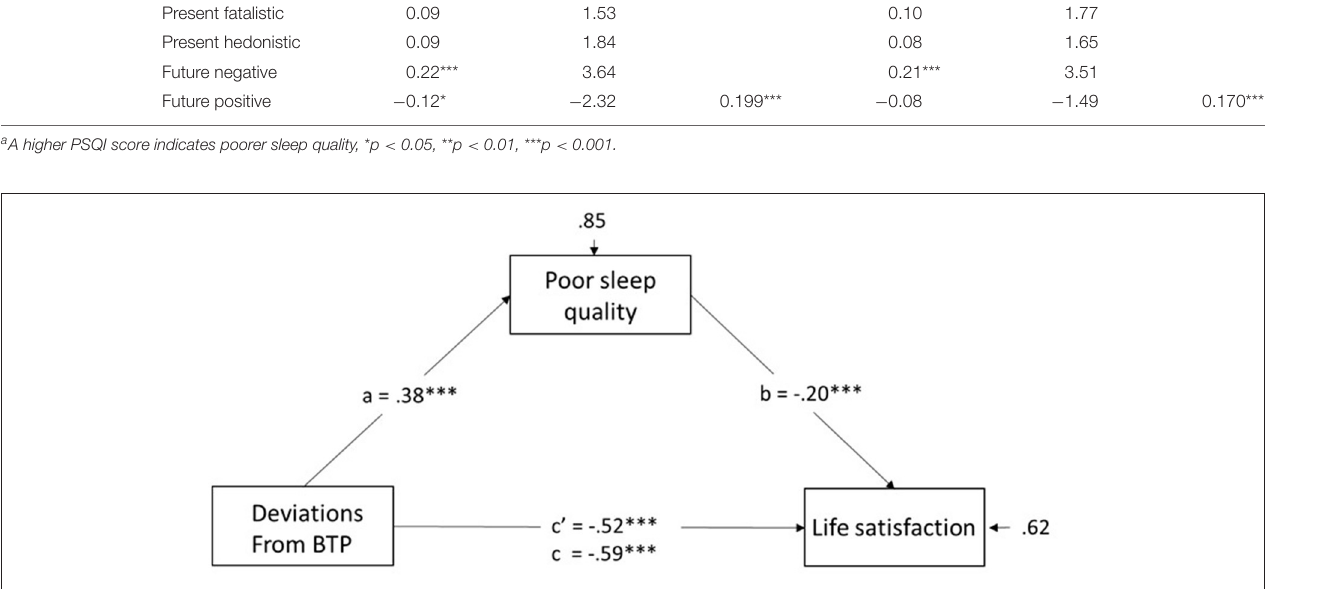
FIGURE 1 | Mediational model where the relation between deviations from a balanced time perspective is mediates by poor sleep quality. c’, direct effect of DBTP on life satisfaction. c, total effect of DBTP on life satisfaction. *** p <